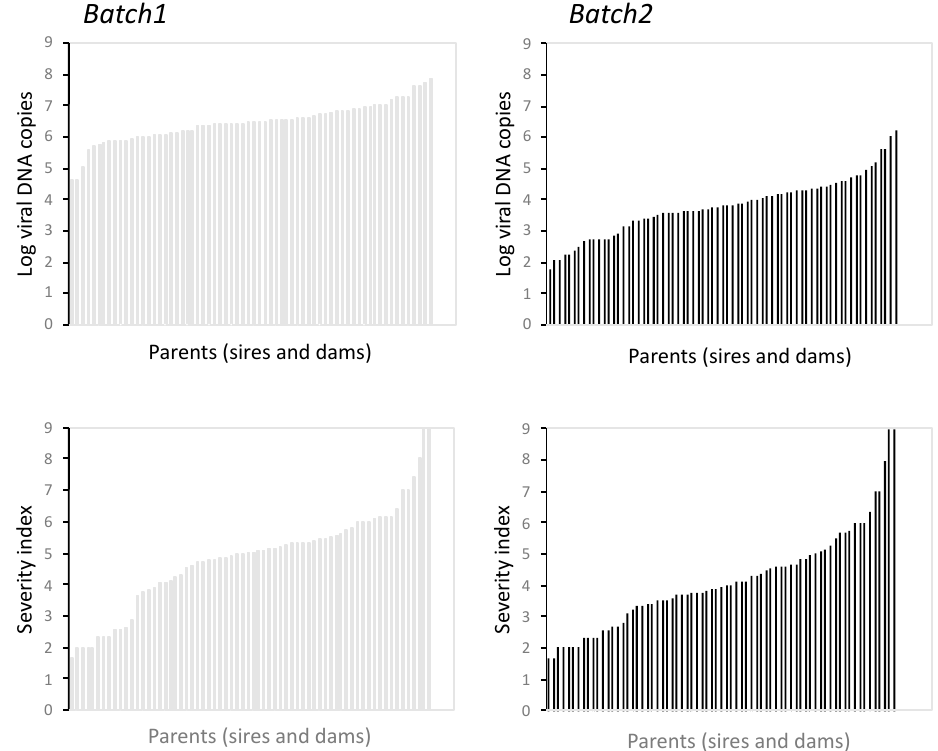
Figure 5. Variation in LCDV DNA copies in logaritmic scale and severity index of sire and dam families for batch 1 (left panel) and batch 2 (right panel).